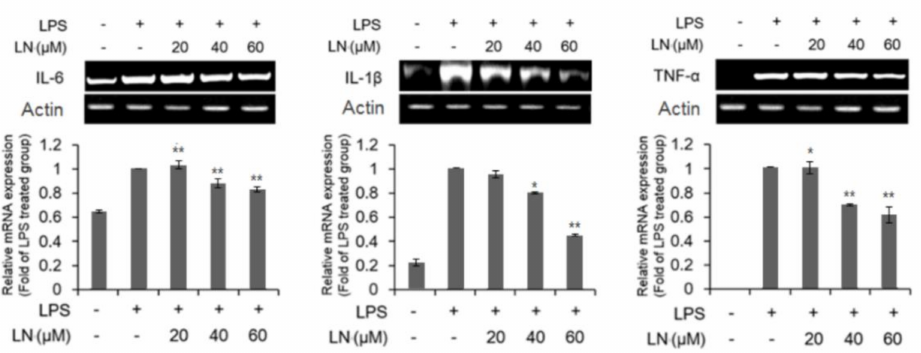
Figure 3. Lutonarin (LN) reversed LPS-induced elevations in proinflammatory cytokines. Macrophages were pretreated with the indicated LN concentration for 4 h, and then cultivated with 1 µ g/mL LPS for 24 h. The mRNA levels were measured by reverse transcriptase polymerase chain reaction (RT-PCR). Actin was used as an internal control. Values are expressed as mean ± SEM of three independent replicates and compared to cells treated with LPS only. * p < 0.05 and ** p < 0.01 by